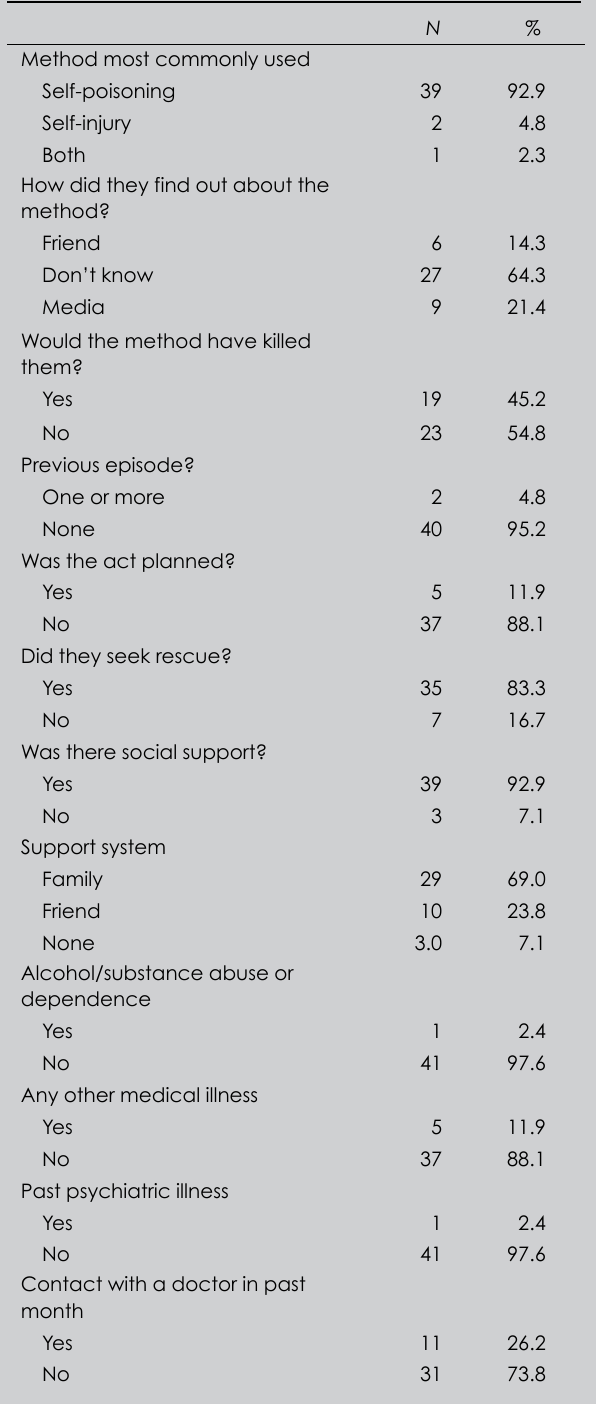
Table III. Recent stressful life events prior to DSH Table II. Data on DSH ( N